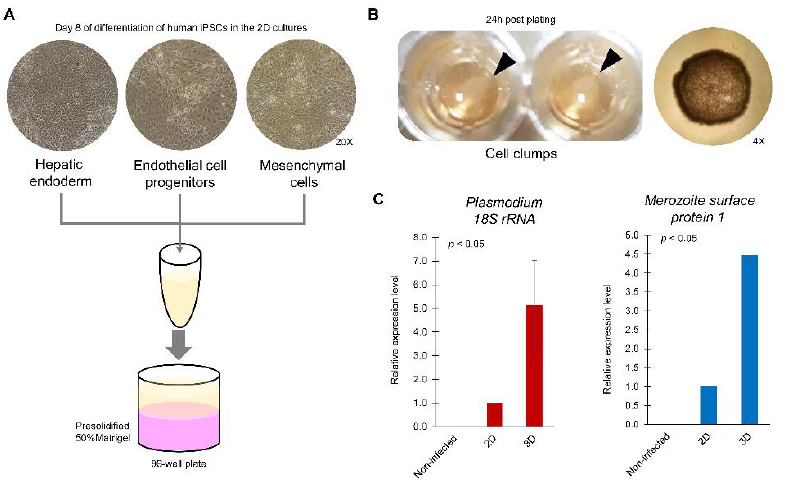
Figure 3. Potential of liver bud-like cell clumps to model liver-stage malaria. ( A ) Protocol to generate hepatic endodermal, endothelial and mesenchymal cells from the human iPSC MUi019 line. Cells were harvested from a monolayer of 2D culture and mixed in culture medium. The cell mixture was then added to a presolidified 50% Matrigel (pink) and allowed to settle on the surface. ( B ) At 24 h of cell plating, the cells had shrunk and became clumped (arrowheads). Microscopic observation revealed the round shape of a cell clump (4× objective lens). ( C ) At day 6 post inoculation of P. vivax sporozoites, the mRNA expression of Plasmodium 18S rRNA and merozoite surface protein 1 in the 3D culture of liver bud-like cell clumps was higher than that in the 2D culture of human hepatocytes derived from the human iPSC MUi019